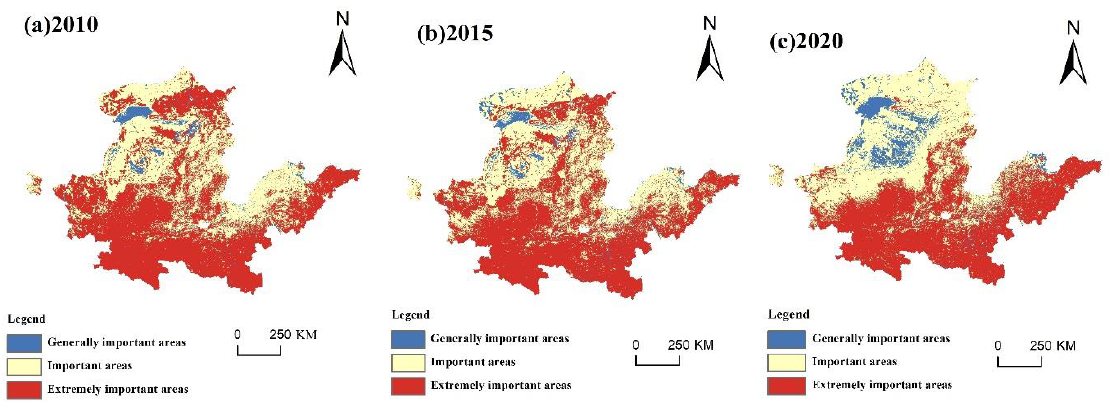
Figure 4. Spatial and temporal patterns of the revised protection levels of ecological importance from 2010 to 2020.